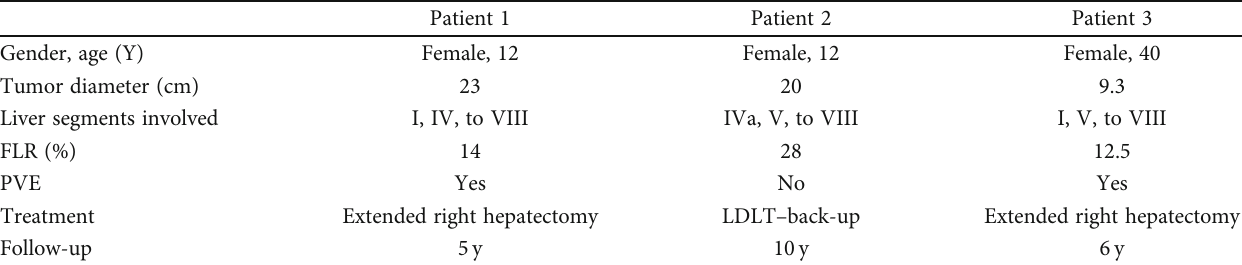
Table 1: Patients ’